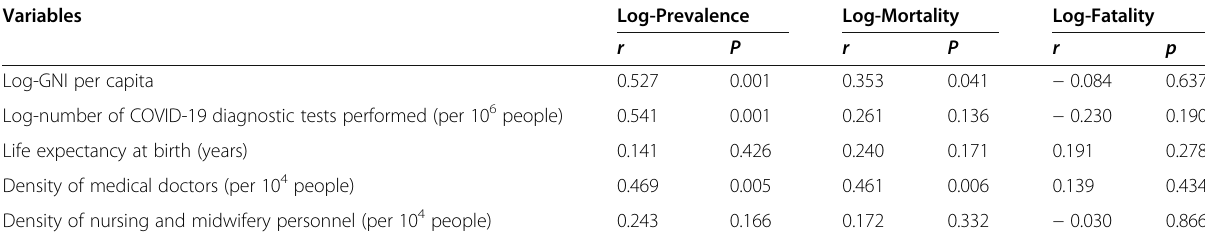
Table 3 Correlation between log-transformed of epidemiologic parameters and possible confounders in selected countries with GNI-per capita more than $15,000